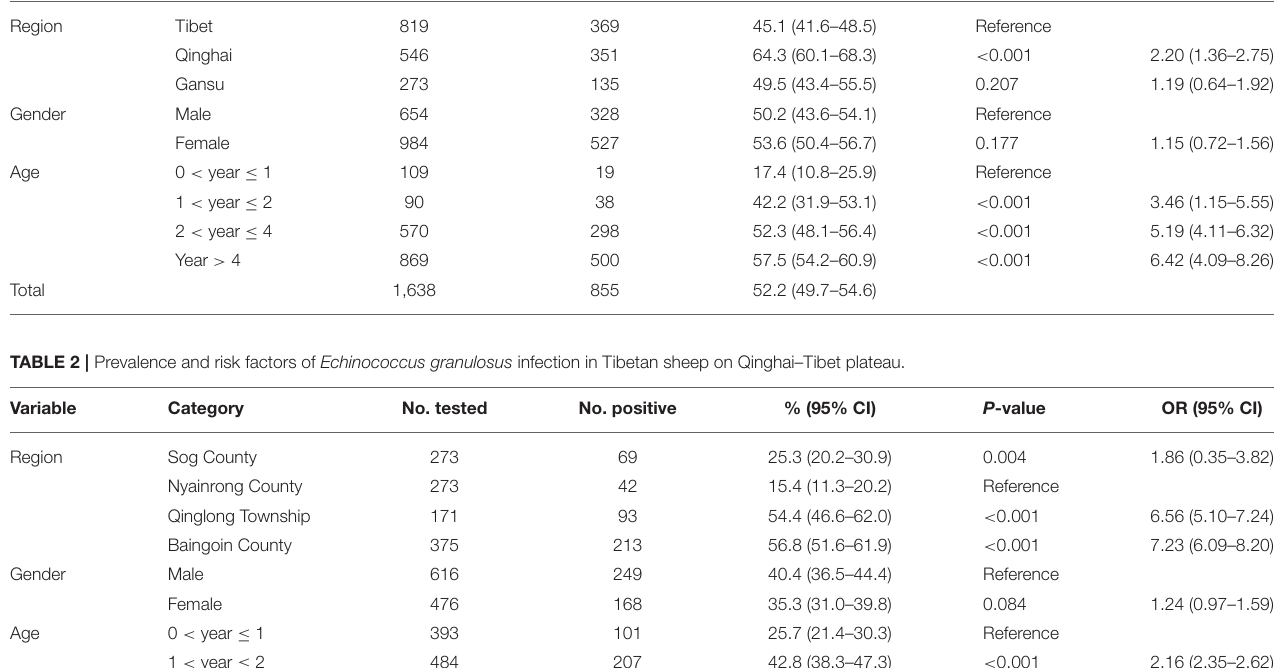
TABLE 1 | Prevalence and risk factors of Echinococcus granulosus infection in yaks on Qinghai–Tibet plateau. Variable